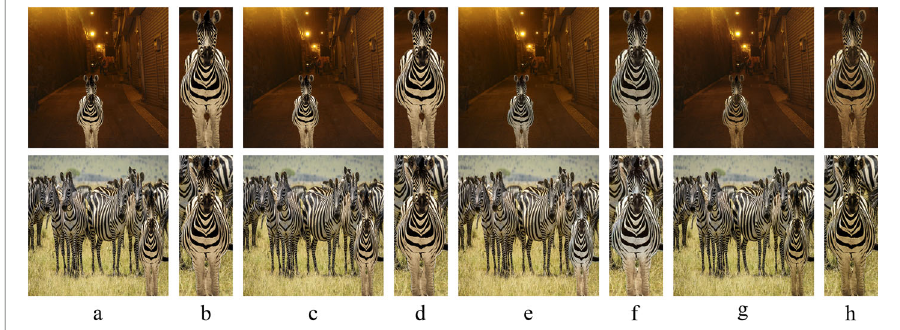
Fig. 9 Real example with same foreground and different backgrounds. a Cut-and-paste. b Partial enlarged details in a . c RC [2]. d Partial enlarged details in c . e DIH [3]. f Partial enlarged details in e . g Our